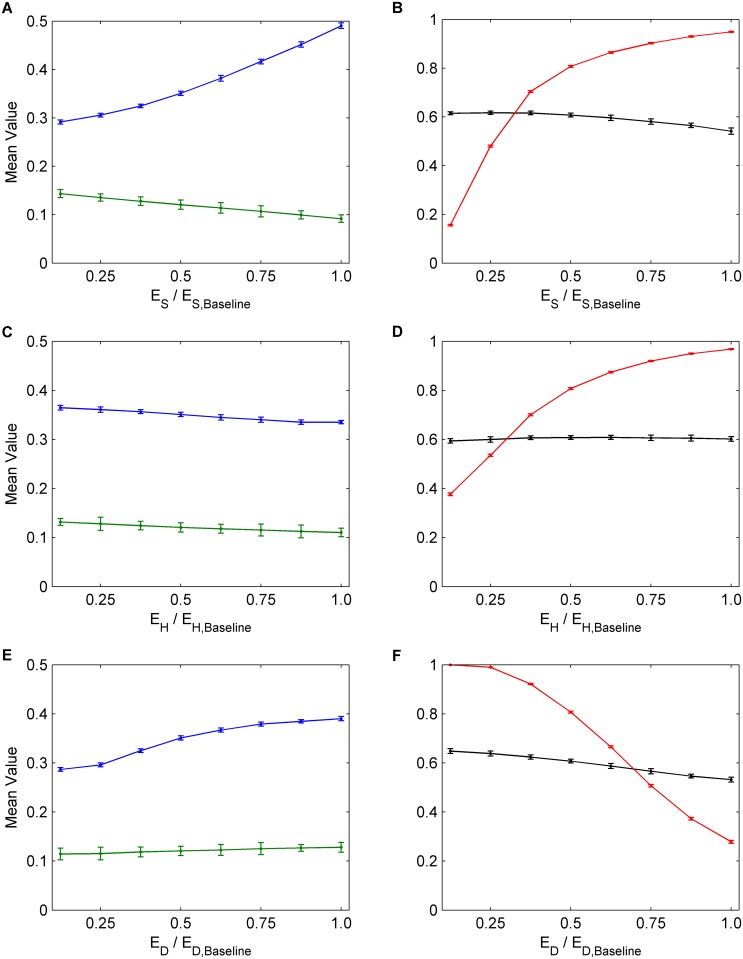
The effects of social parameters on interventions.Univariate sensitivity analysis for parameters E
S, E
H, and E
D. The numbers on the horizontal axes correspond to multiples of the baseline values for E
S, E
H, and E
D, hence 1.0 corresponds to the baseline value of the each parameter. (a), (c), (e) Average values across 30 seasons for vaccination coverage (blue) and incidence (green). (b), (d), (f) Average values across 30 seasons for NPI usage amongst susceptible individuals (black) and infectious individuals (red). Confidence intervals represent two standard deviations of the mean of the 100 parameter sets across 30 simulated seasons.